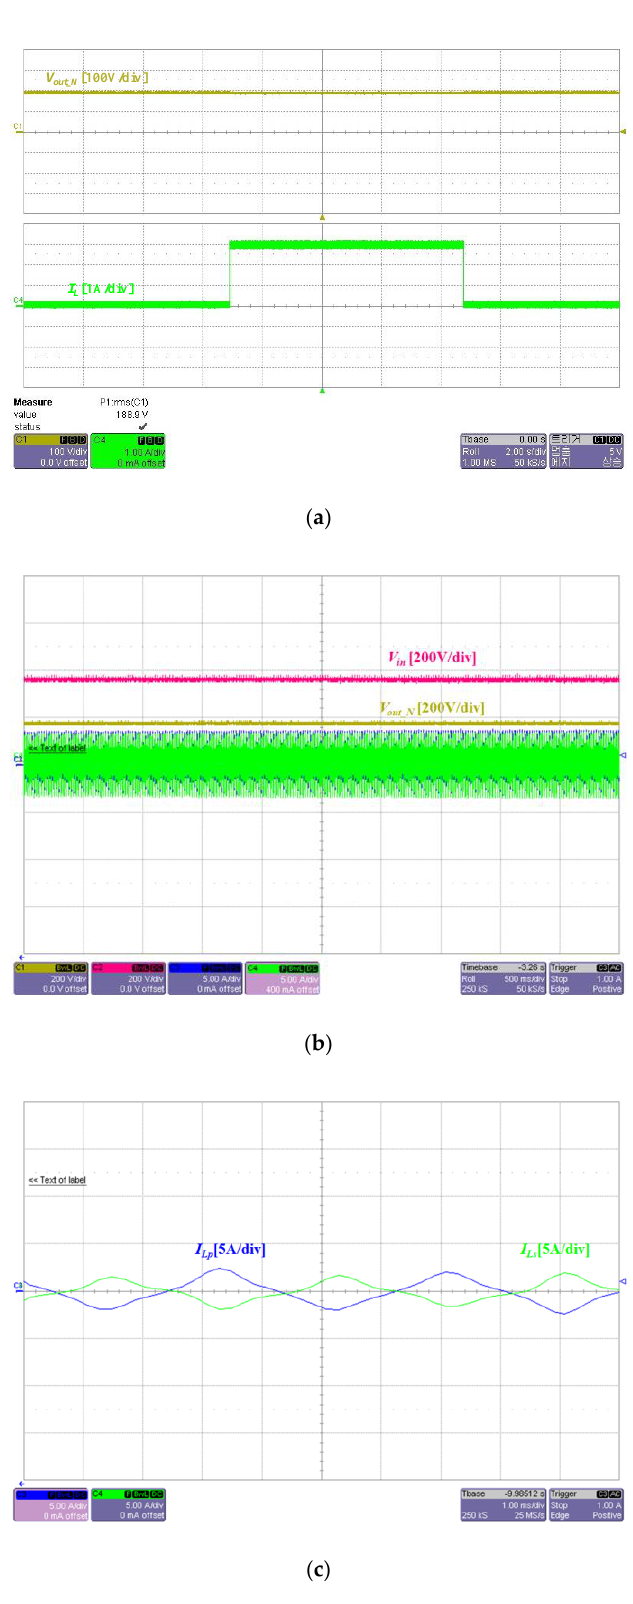
Figure 11. Experimental waveforms under balanced load condition: ( a ) Waveforms of input voltage, negative pole voltage, and total inductor current, ( b ) waveforms of negative pole voltage and inductor currents under balanced load condition, ( c ) enlarged waveforms of inductor currents.